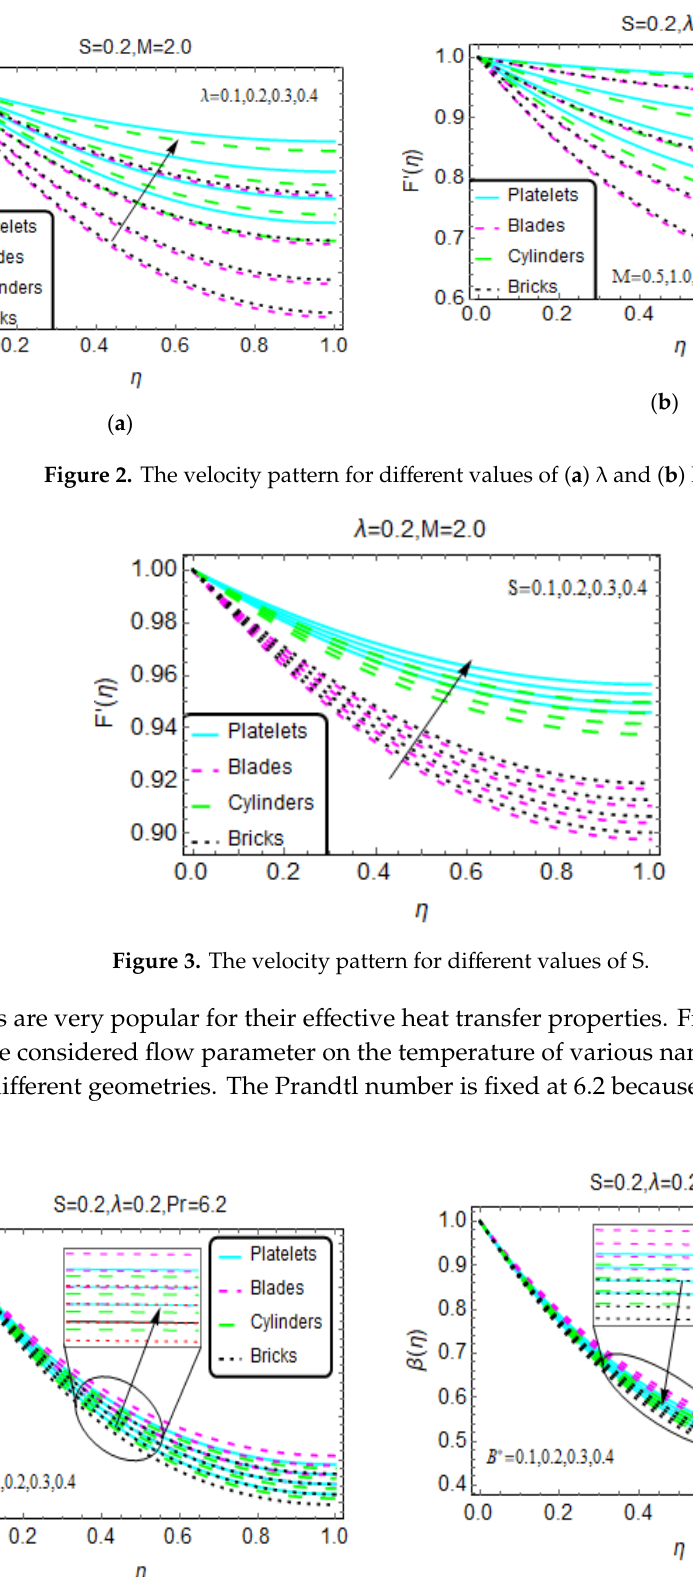
Figure 4. The temperature pattern for different values of ( a ) A ∗ and ( b ) B ∗ .